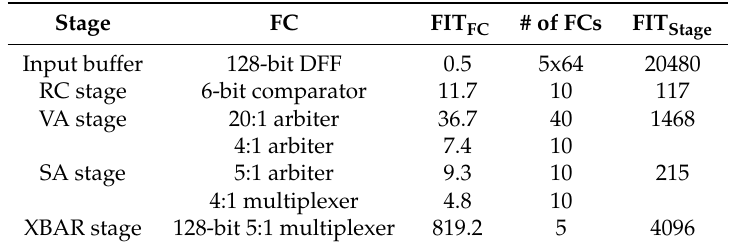
Table 1. Failure in time (FIT) values of the baseline